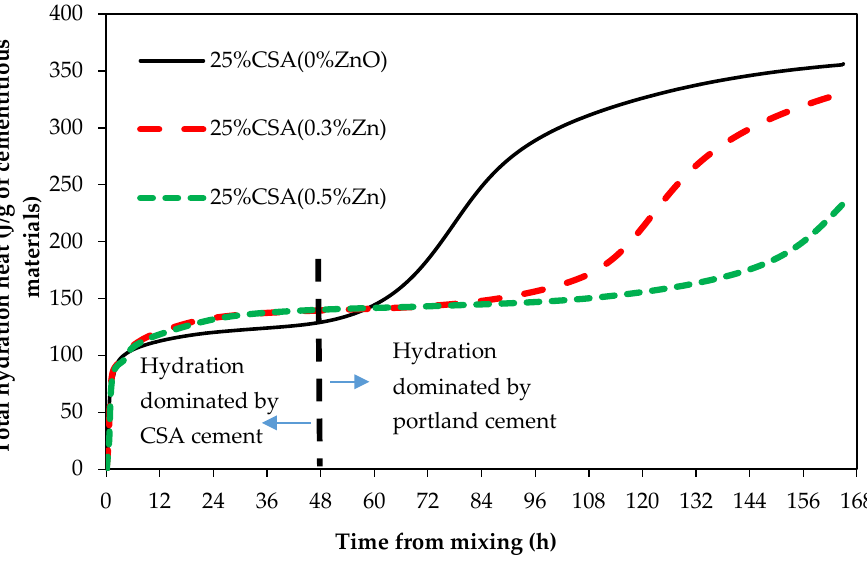
Figure 9. Total heat of hydration of samples containing 25% CSA .